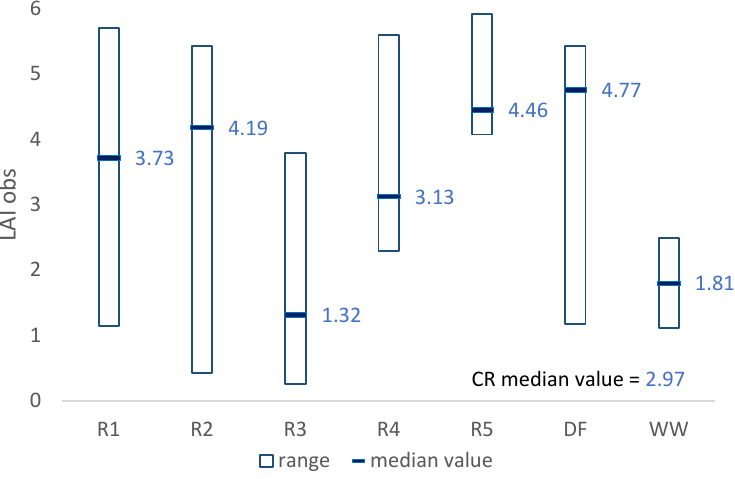
Figure 3. Ranges and median values of observed LAI values for the studied sites.